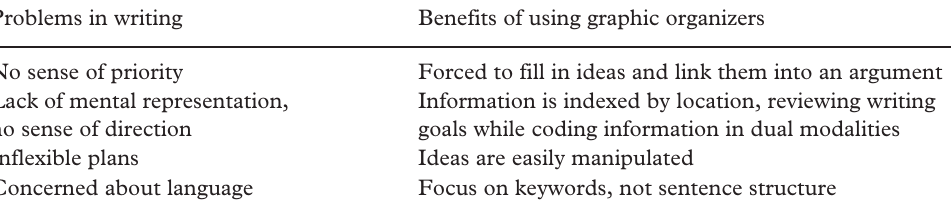
Table 1. Graphic organizers to scaffold